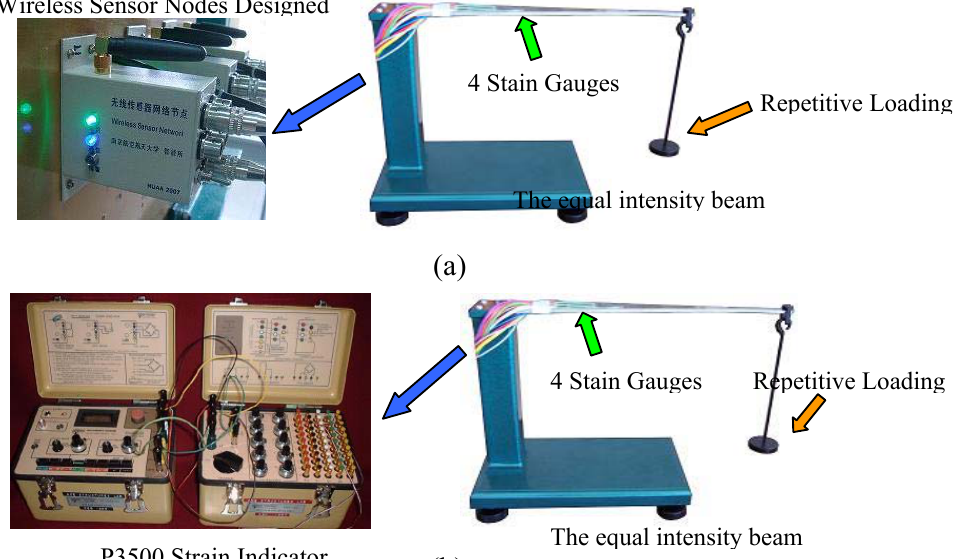
Figure 4. The picture of tests setup for static error and repeatability error. (a) Tests for output voltage under repetitive Loadings. (b) Tests for strain changes under repetitive